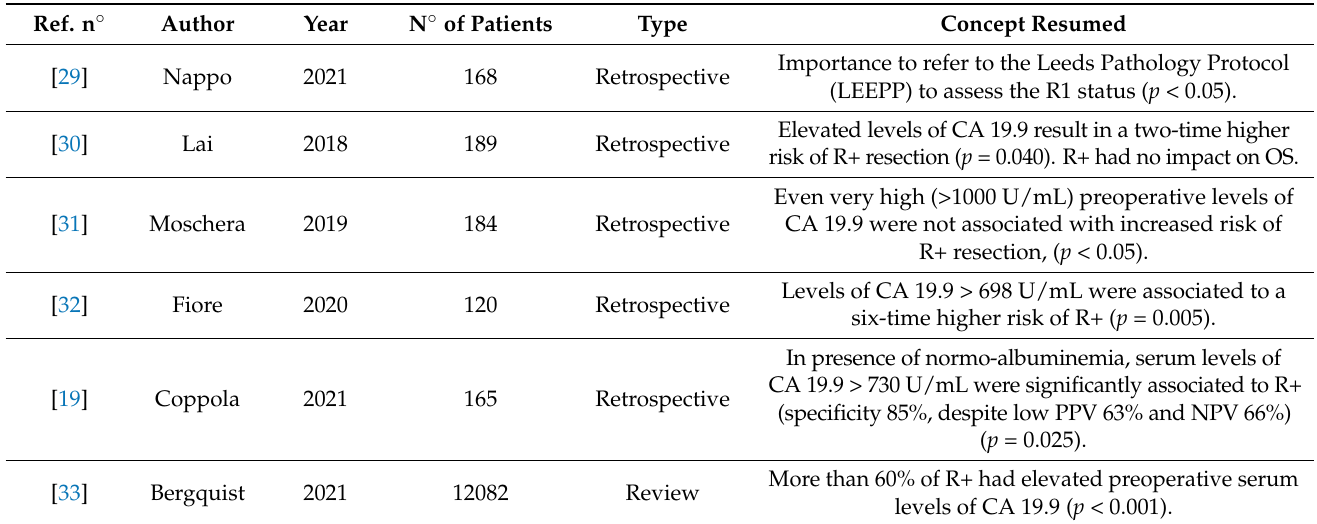
Table 2. Main characteristics and findings of studies reporting data about association between CA 19.9 levels and margin